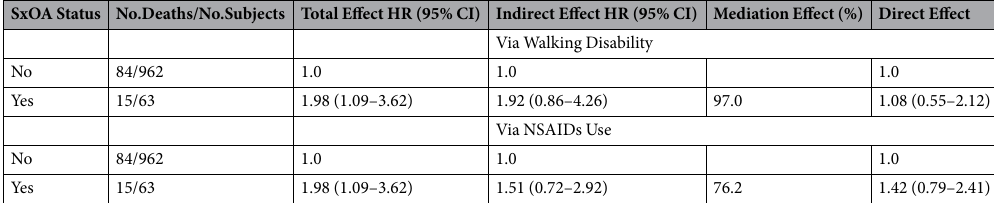
Table 3. Total, Direct and Indirect Effect of Knee SxOA on All-Cause Mortality Mediated through Walking Disability and Use of NSAIDs. * Adjusting for age, sex, BMI, education, income level, level of daily physical activity, and